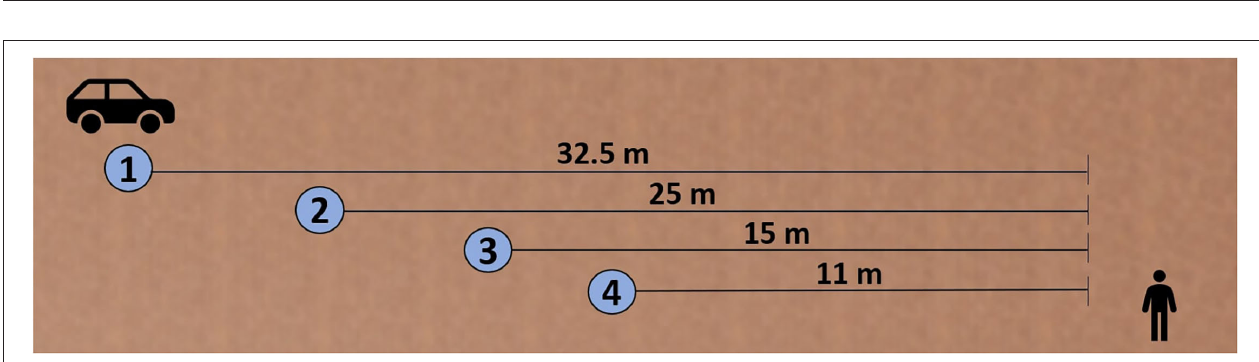
FIGURE 2 | Procedure for the yielding conditions in this study: 1. Video starts in 32.5m, 2. First deceleration from 30 to 20km/h starting in 25m, 3. Second deceleration from 20km/h to 2km/h starting in 15m, 4. Video stop in 11m (distances measured from the vehicle’s bumper to the pedestrians’ position; m = meter).